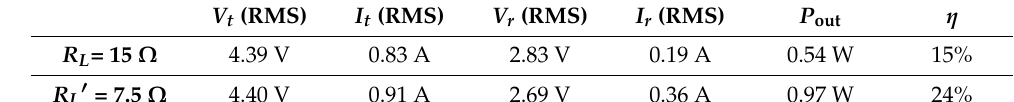
Table 4. Variation in system parameters for the load resistance shifted from 15 Ω to 7.5 Ω.